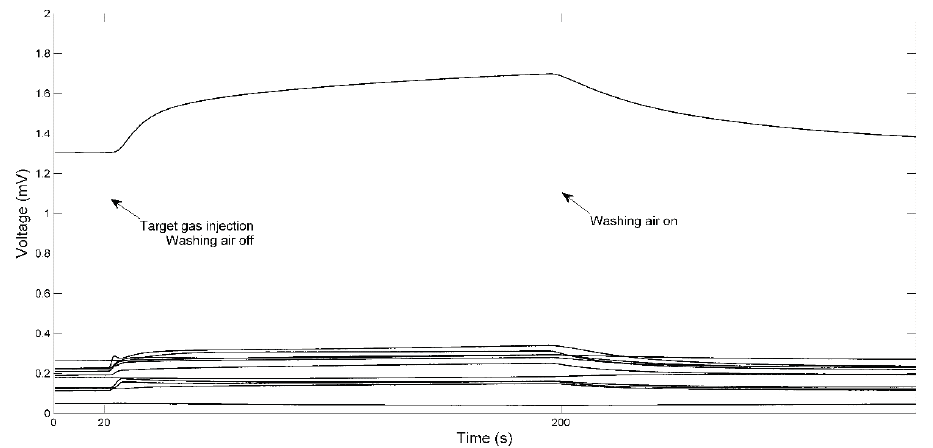
Figure 2. Example of responses of 12 sensors to ginseng